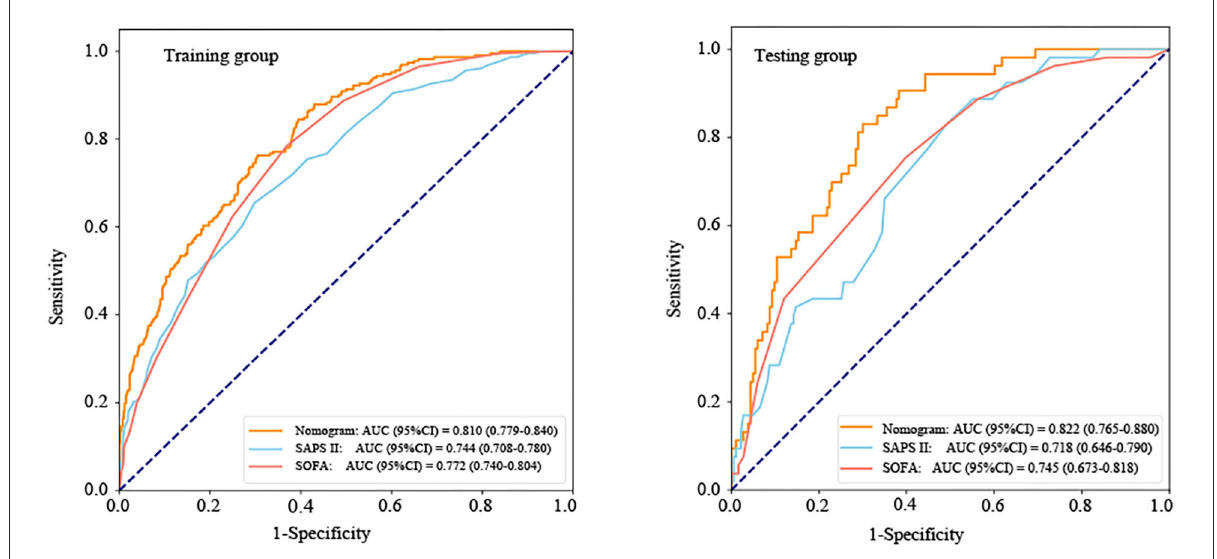
FIGURE5 The receiver operator characteristic (ROC) curves of the nomogram and other scoring system. AUC, area under the curve; CI, confidence interval; SOFA, sequential organ failure assessment; and SAPS II, simplified acute physiology score II.